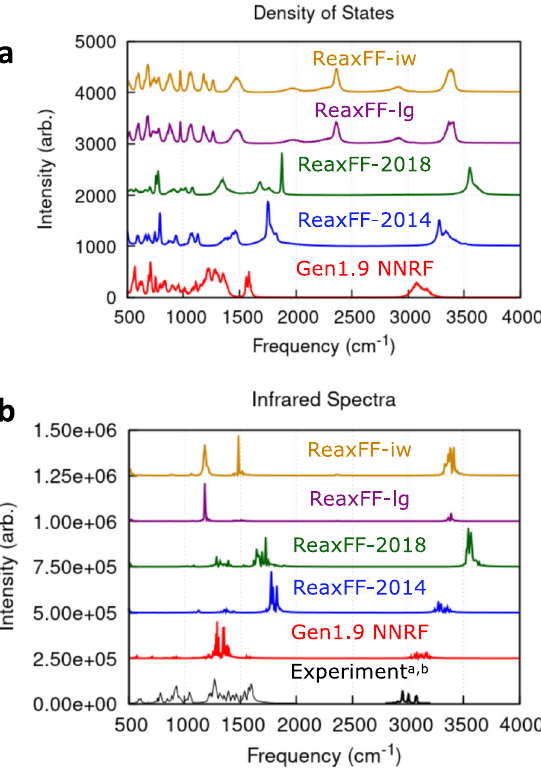
Fig. 8 The vibrational properties of RDX crystal. a Density of states and b infrared Spectra of RDX comparing Gen 9 NNRF with four parameterizations of ReaxFF. Similarities between ReaxFF-2014 and ReaxFF-2018 are much closer to NNRF, as compared to ReaxFF-lg and ReaxFF-iw. a,b Experimental FTIR data from refs. 52 and 53 .